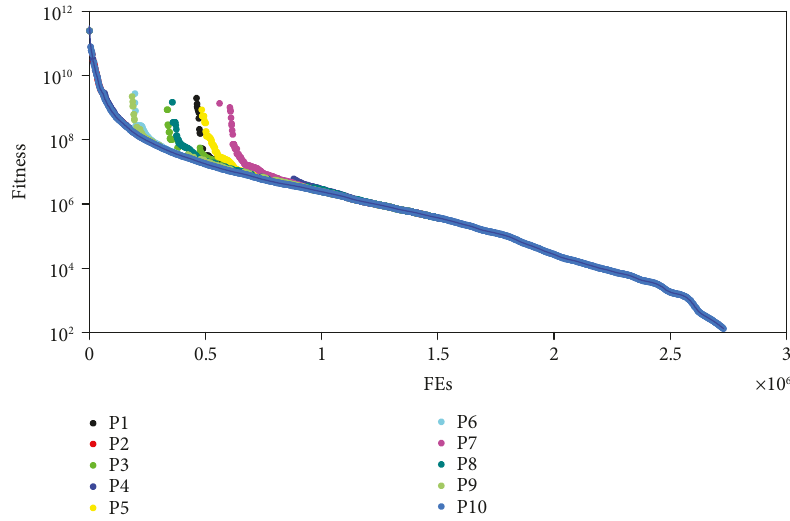
Figure 6: Convergence curves of active child populations in the 17th subproblem when optimizing F9